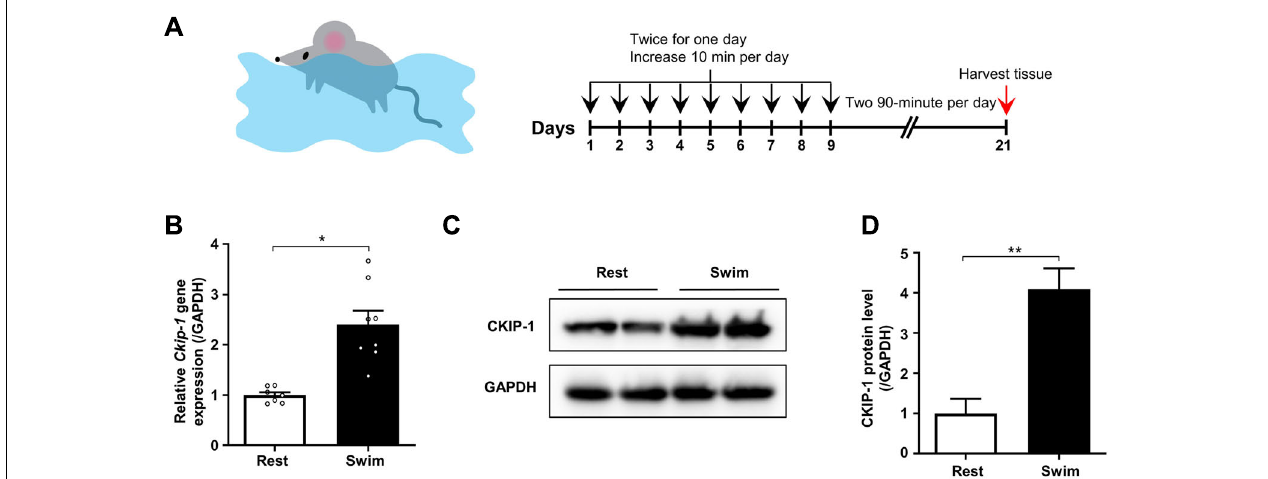
FIGURE 1 | CKIP-1 expression changes in the hearts of mice after 21 days swimming exercise. (A) Schematic representation of swimming exercise induced physiological cardiac hypertrophy model in mice. (B) CKIP-1 mRNA levels assessed by quantitative polymerase chain reaction in mouse heart tissues from WT mice with 21 days swimming exercise, normalized to GAPDH. n = 7 replicates from rest mice and n = 8 replicates from swimming mice. (C) Western blot analysis of CKIP-1 expression in total protein extracts from rest and swimming exercise hearts with 21 days training ( n = 3). (D) Quantification of CKIP-1 protein levels. Values are means ± SEM, ∗ P < 0.05, ∗∗ P < 0.01. Statistical differences between two groups were determined by the unpaired two-tailed Student’s t-test. CKIP-1, casein kinase-2 interacting protein-1; WT, wild type; GAPDH, glyceraldehyde 3-phosphate